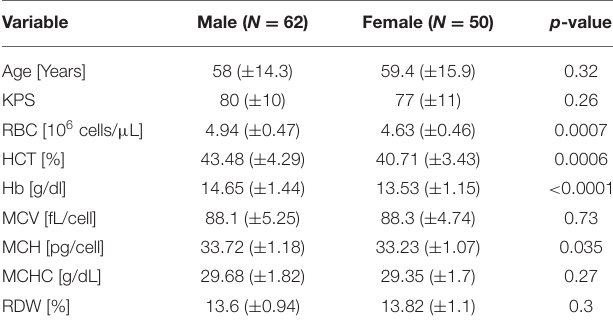
TABLE 2 | Main variables of the treated group by gender distribution.